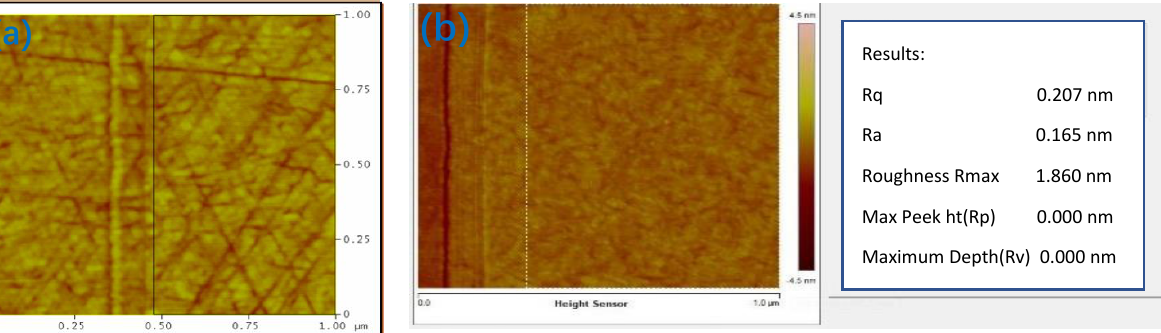
Figure 16. Comparison of AFM images of a slider surface produced under normal and improved conditions: ( a ) surface produced under normal conditions; ( b ) surface produced under improved conditions.